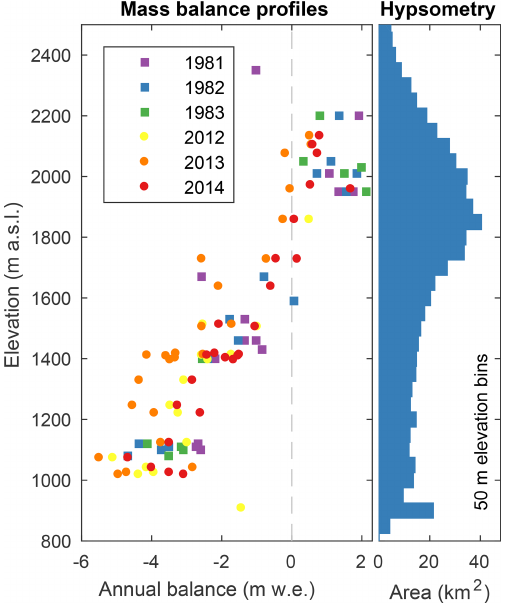
Figure 12. Annual point mass balances measured with the glacio- logical method on West Fork, Susitna, East Fork, Maclaren, and Eureka glaciers. The apparent outlier in 2012 ( − 1 . 4mw.e. at 908ma.s.l.) was due to debris cover at the site. The hypsometry of all 127 glaciers in the Alaska Range portion of the Susitna basin is also shown in 50m elevation bands. The hypsometry comes from the Randolph Glacier Inventory (Pfeffer et al., 2014), which used glacier outlines from 2009 and elevation from airborne interferom- etry (http://ifsar.gina.alaska.edu, last access: 6 December 2018) col- lected in summer